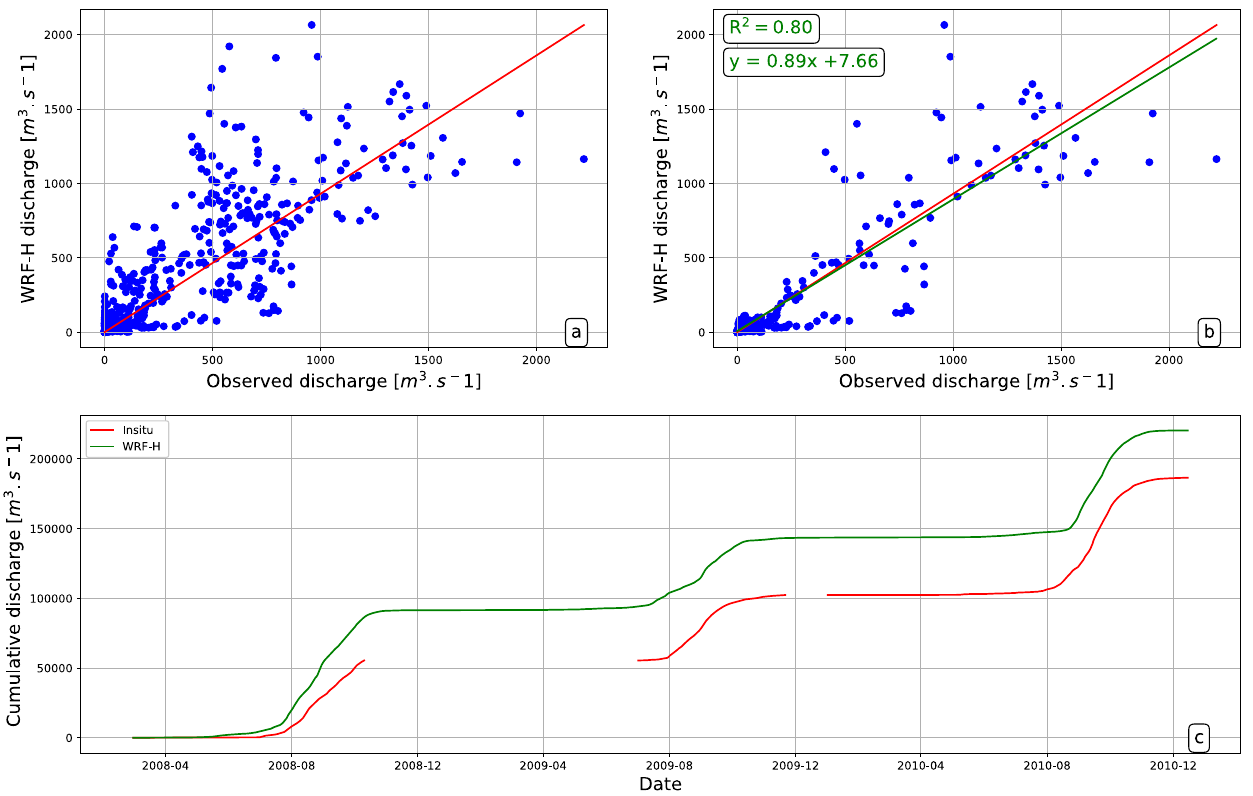
Figure 11. Scatter plot showing comparison of simulated and observed discharges ( a ) for the period 2008–2010, and ( b ) for the flooding year 2010, and ( c ) the cumulative of simulated and observed discharge at Savè.